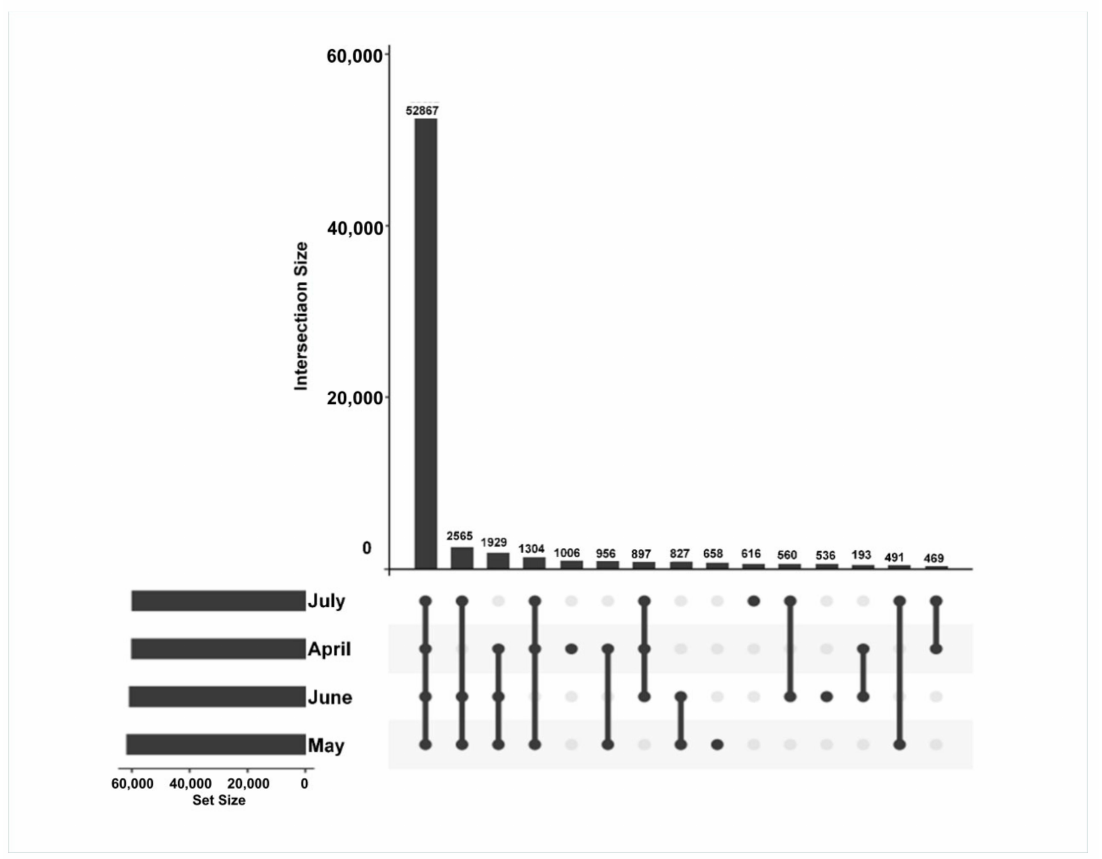
Figure 4. Gene intersection matrix profiles for A. argyi samples collected at four time